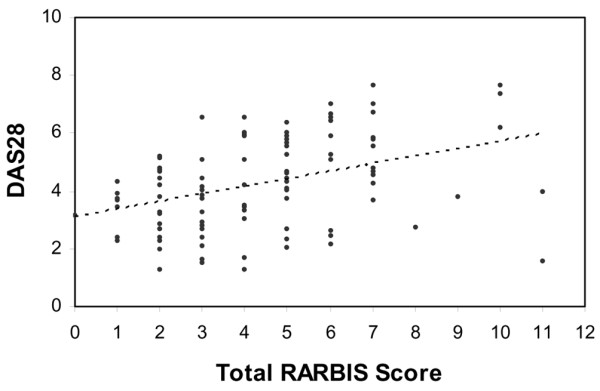
Scatter plot of the rheumatoid arthritis medical records-based index of severity (RARBIS) versus the 28-joint Disease Activity Score 28 (DAS28).